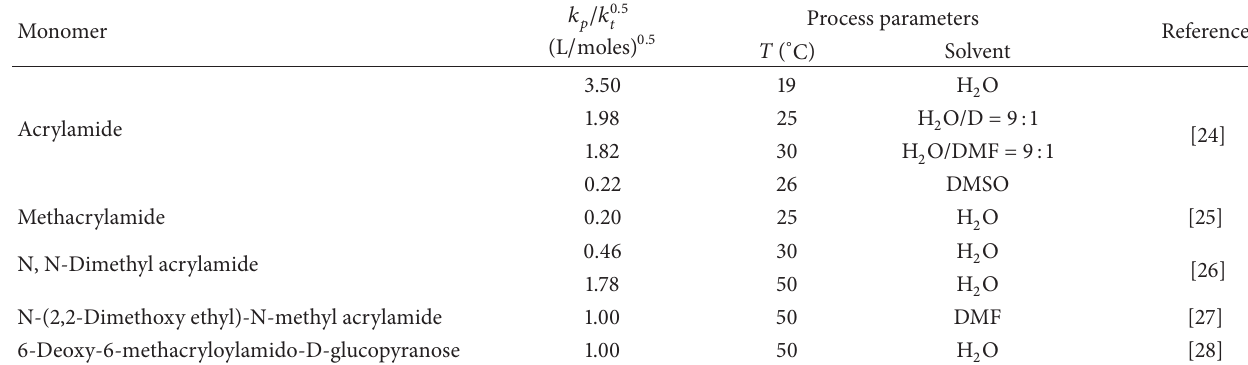
Table 2: 𝑘 𝑝 /𝑘 0.5 𝑡 values for different acrylamide and methacrylamide.